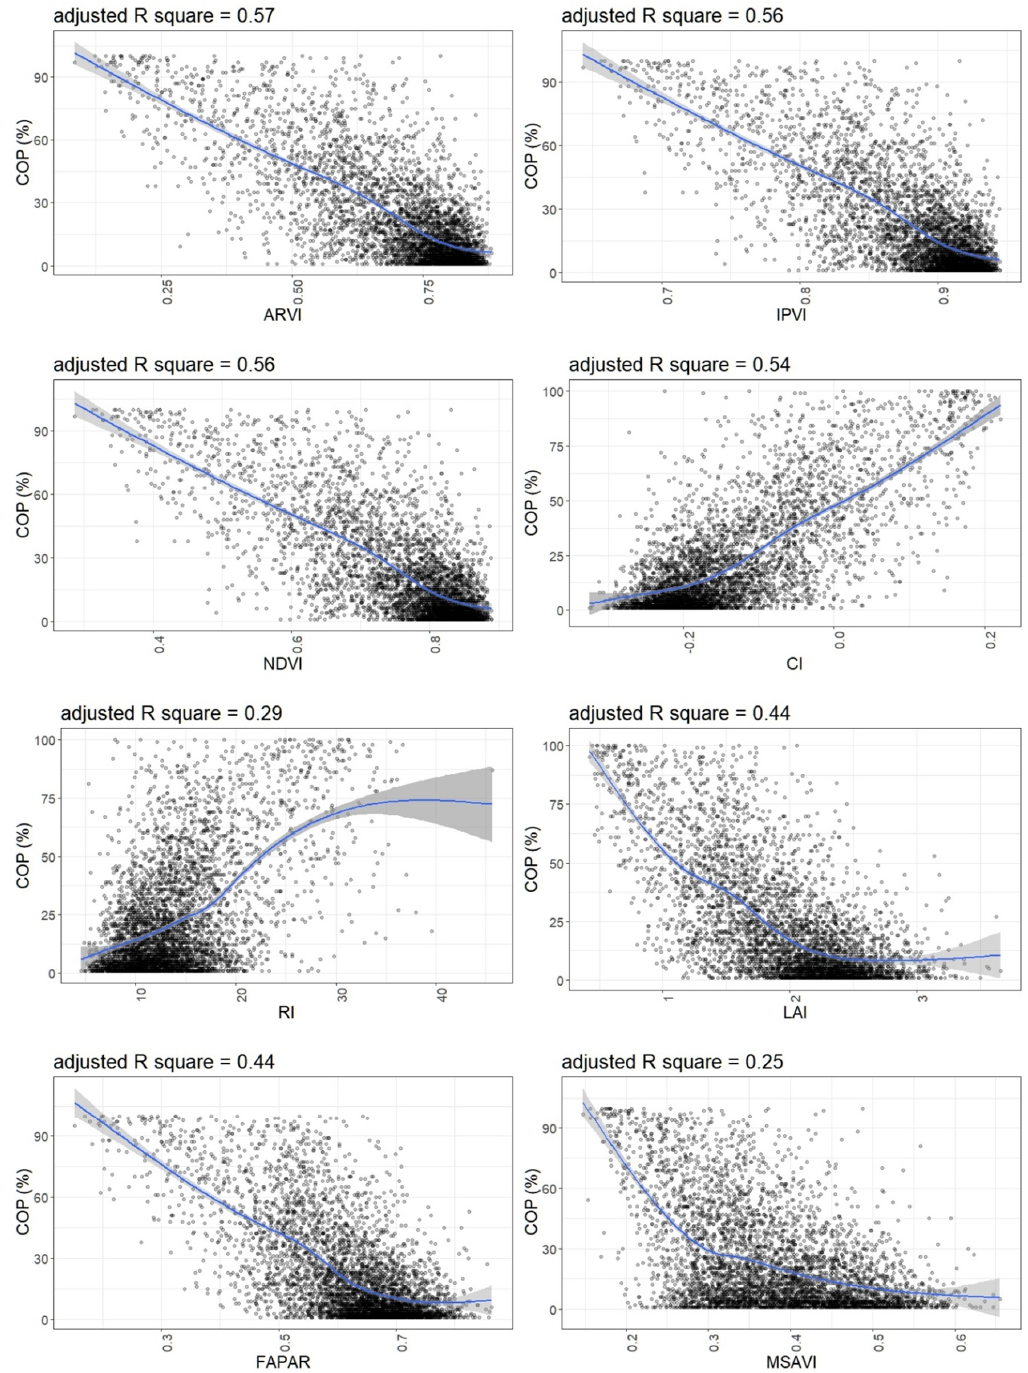
Figure 3. The relationship between individual predictors and canopy openings percentage (COP) with included local regression line (LOESS).